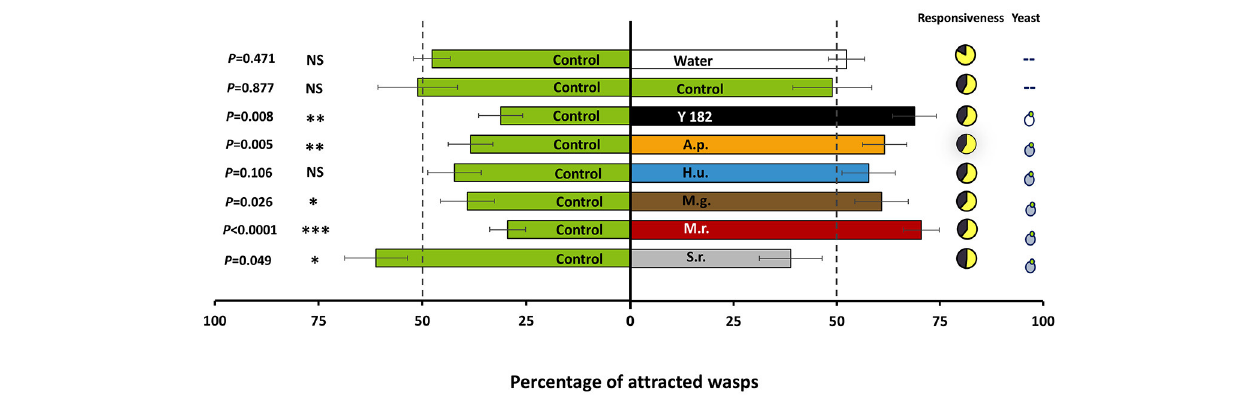
FIGURE 2 | Olfactory response of adult Aphidius ervi females when given the choice between two odors (percentage ± SE, n = 100). Treatments included: Control, non-inoculated, yeast-free nectar; Water, distilled water; Y182, nectar fermented with the reference strain Saccharomyces cerevisiae Y182; A.p., Aureobasidium pullulans -fermented nectar; H.u., Hanseniaspora uvarum -fermented nectar; M.g., Metschnikowia gruessii -fermented nectar; M.r., Metschnikowia reukaufii -fermented nectar; S.r., Sporobolomyces roseus -fermented nectar. Nectar-inhabiting yeasts are marked with a blue yeast-like symbol, whereas the reference strain is marked with a white yeast-like symbol. Experiments were performed with cell-free nectars. The bioassay was carried out by releasing 20 groups of five females at the base of a two-choice Y-olfactometer and evaluating their response 10min after their release. Wasps that passed a set line at the end of the olfactometer arms and were still there at the time of evaluation were considered to have chosen for the odor source connected to that olfactometer arm. Parasitoids that did not make a choice within 10min after release were considered as non-responding individuals, and were excluded from the statistical analysis. Pie charts show the distribution of responding (in yellow) and non-responding (in black) individuals. Asterisks indicate a preference that is significantly different ( t -test) from a 50:50 distribution within a choice test: *** P < 0.001; **0.001 ≤ P < 0.01; *0.01 ≤ P ≤ 0.05; NS, non-significant.